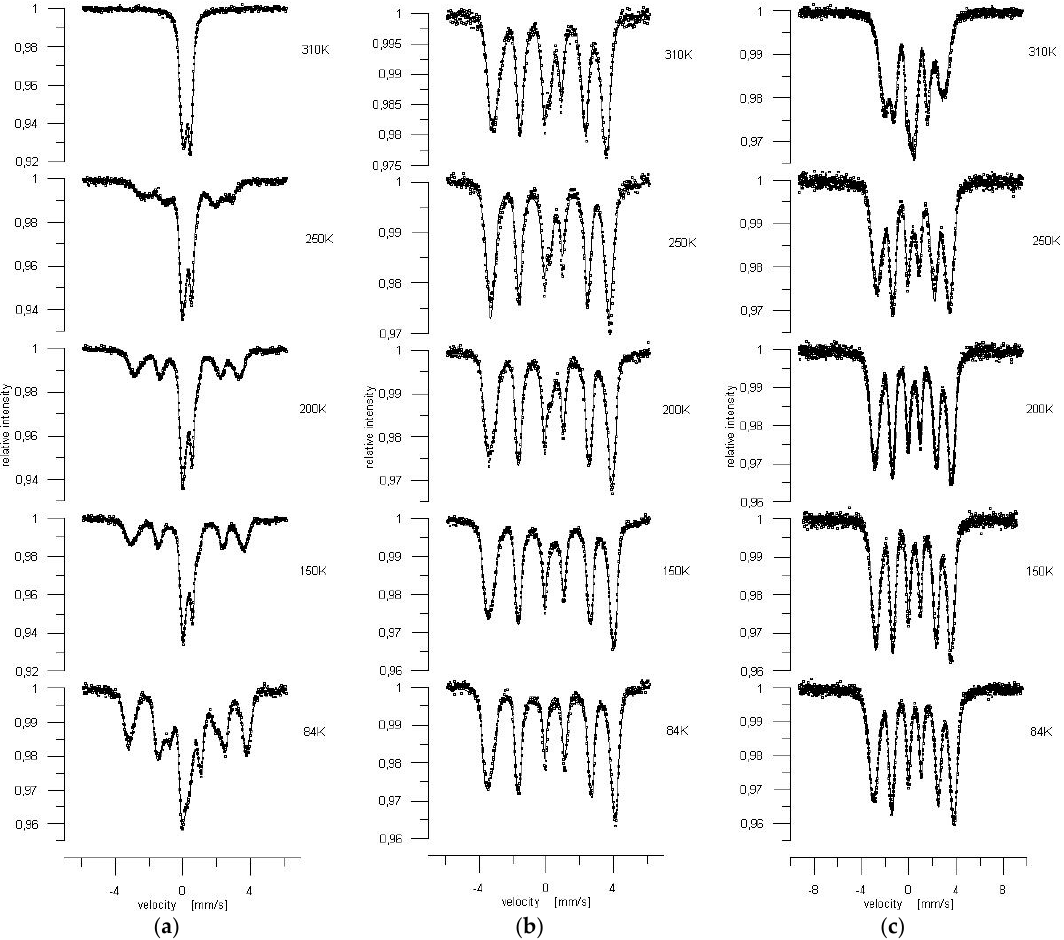
Figure 12. Transmission spectra of: ( a ) the Fe-poor compound MnFeP 0.5 Si 0.5 ; ( b ) the equi-atomic compound Mn 1.4 Fe 0.6 P 0.3 Si 0.7 ; and ( c ) the Fe-rich compound Mn 0.7 Fe 1.3 P 0.65 Si 0.35 , measured at different temperatures.